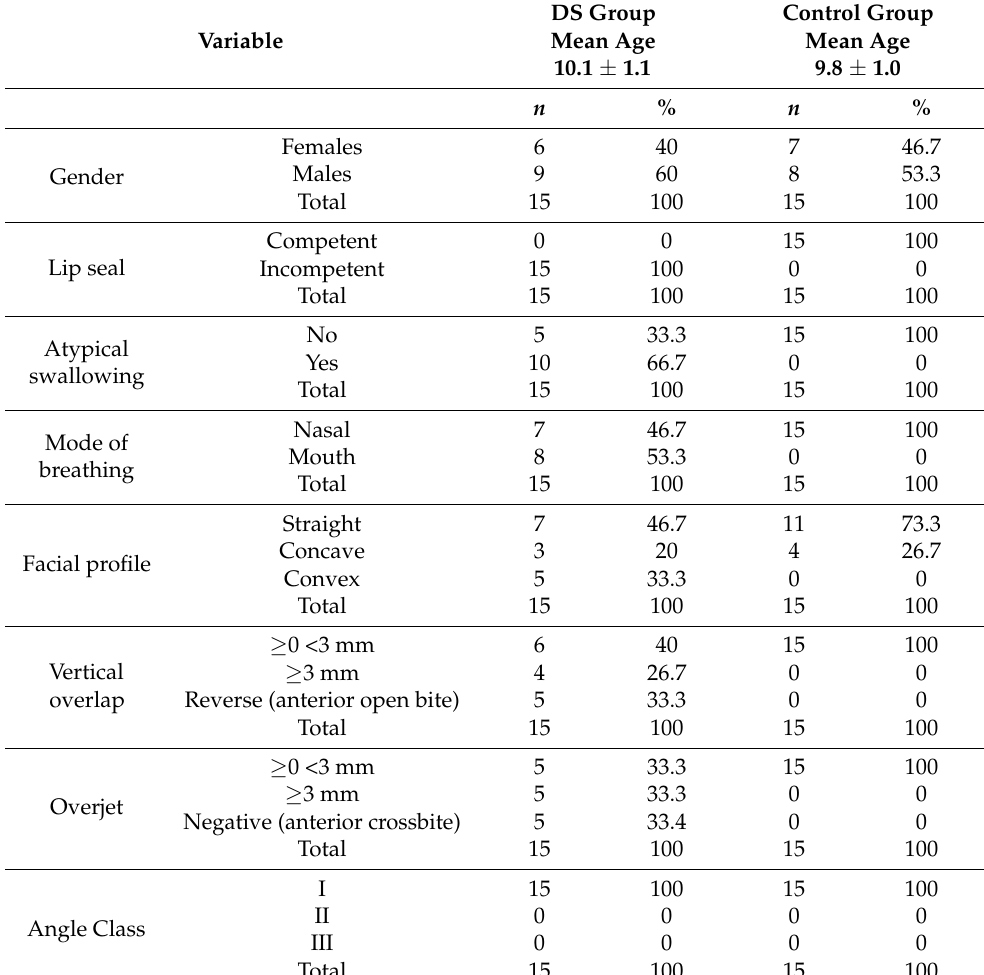
Table 1. The results of the clinical examinations for the DS and control